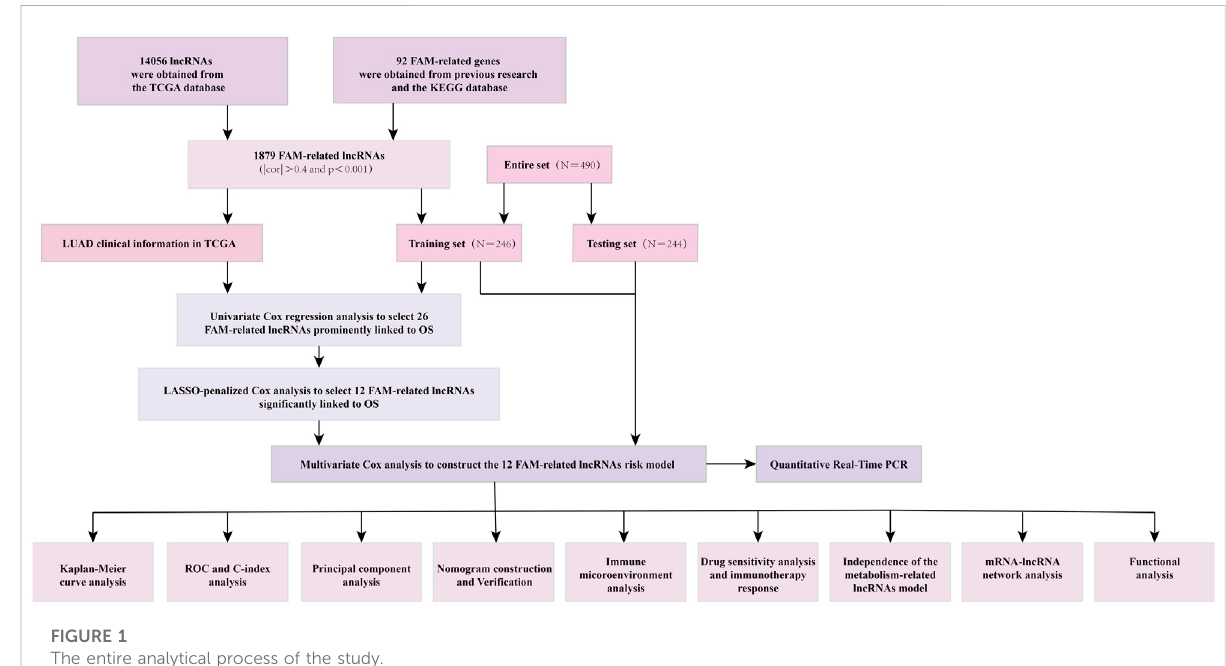
FIGURE 1 The entire analytical process of the study.